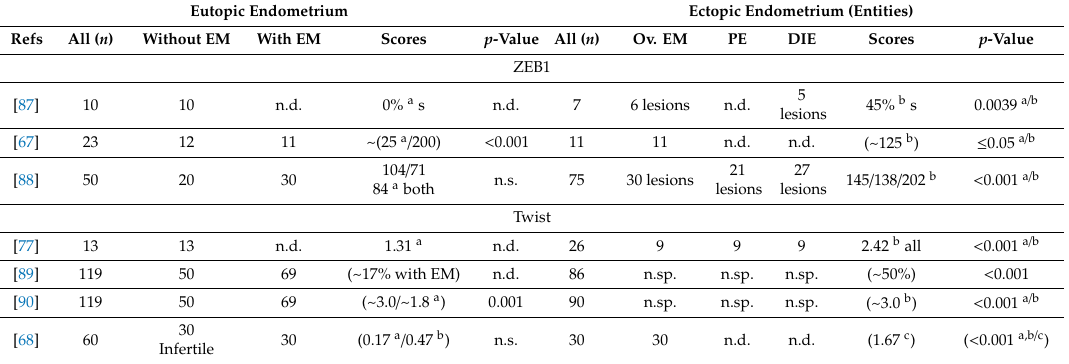
Table 5. Immunohistochemistry of ZEB1 and Twist in eutopic and ectopic endometrium. Eutopic Endometrium Ectopic Endometrium (Entities) Refs All ( n